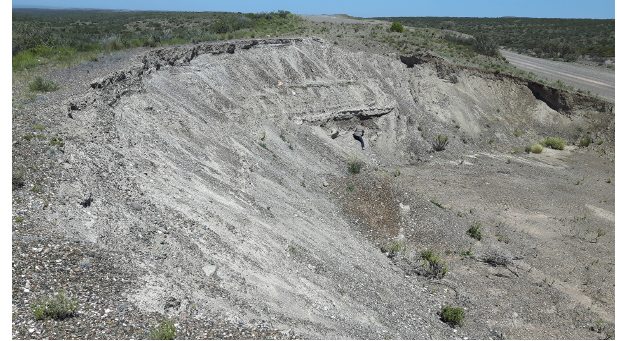
Figure 4. MIS 5 beach ridge deposit near Camarones. The photo illustrates the back side of the beach ridge, with the sea located on the left side of the